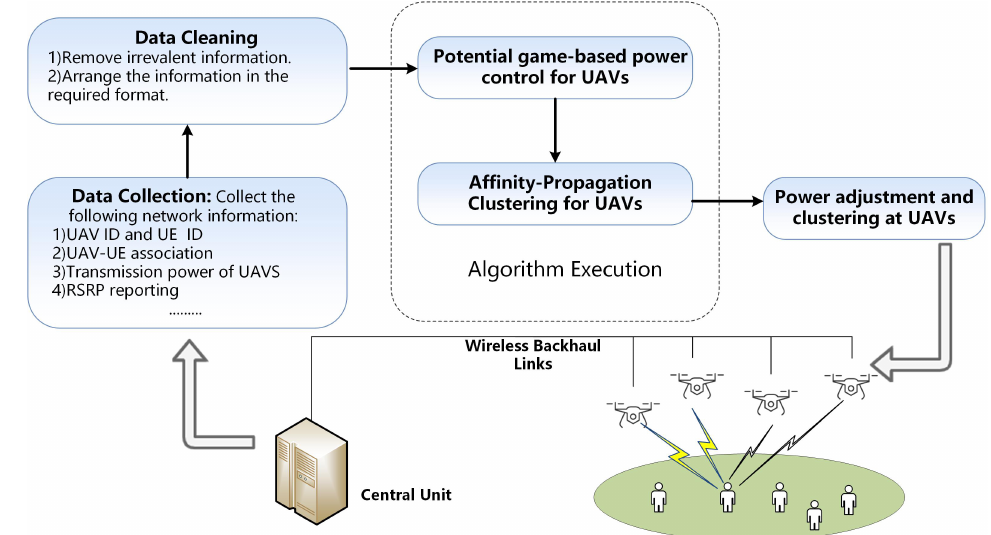
Figure 2. Interference management